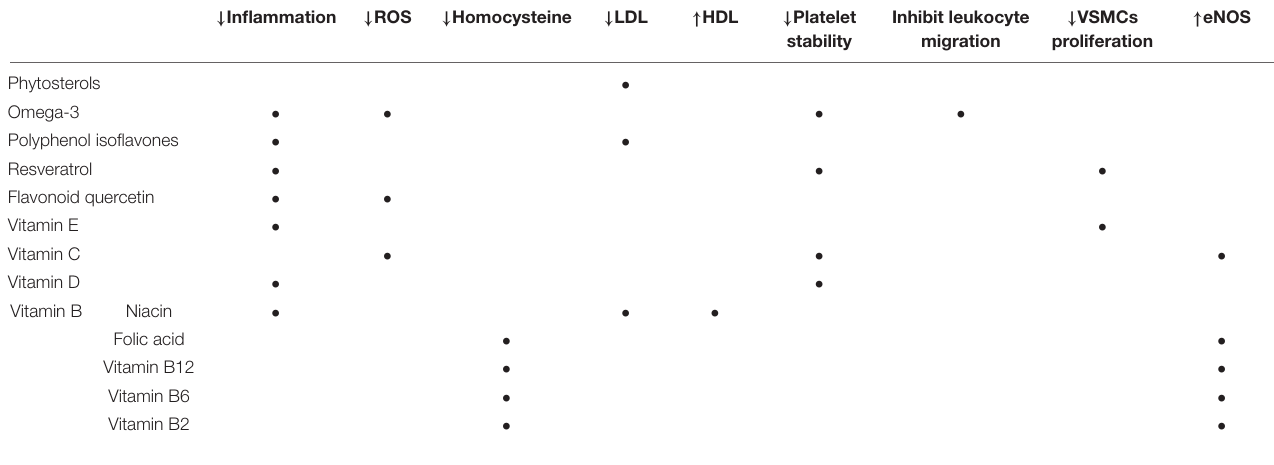
TABLE 1 | Proposed mechanism of nutrients in preventing